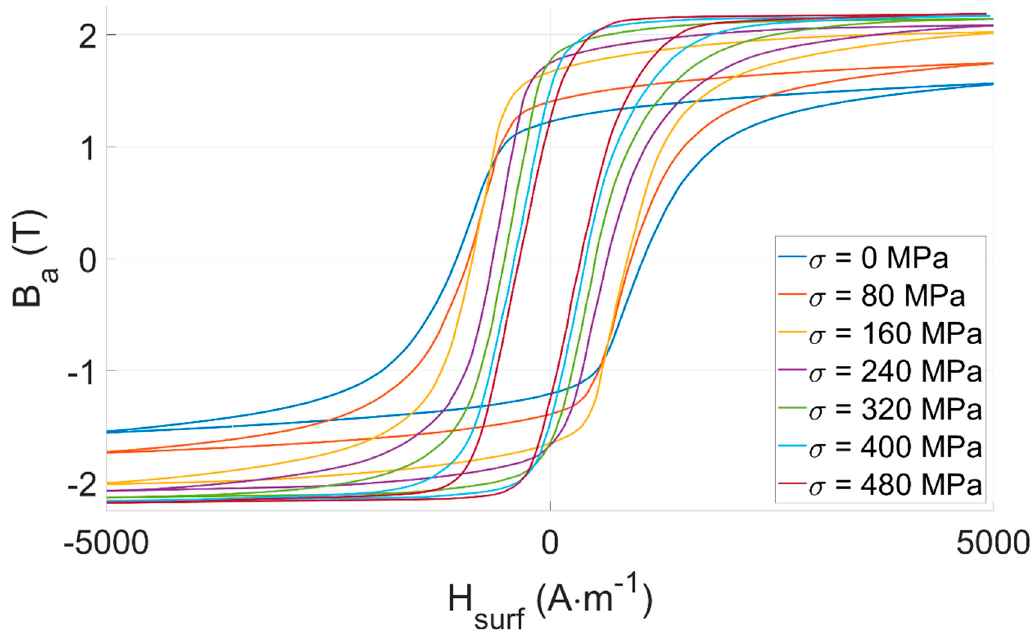
Figure 7. FeCo: experimental measurements for the tensile stress ‐ dependent B a ( H surf ) hysteresis cycles.